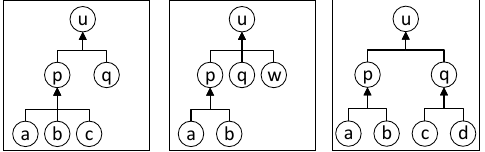
Figure 3: The different circuit